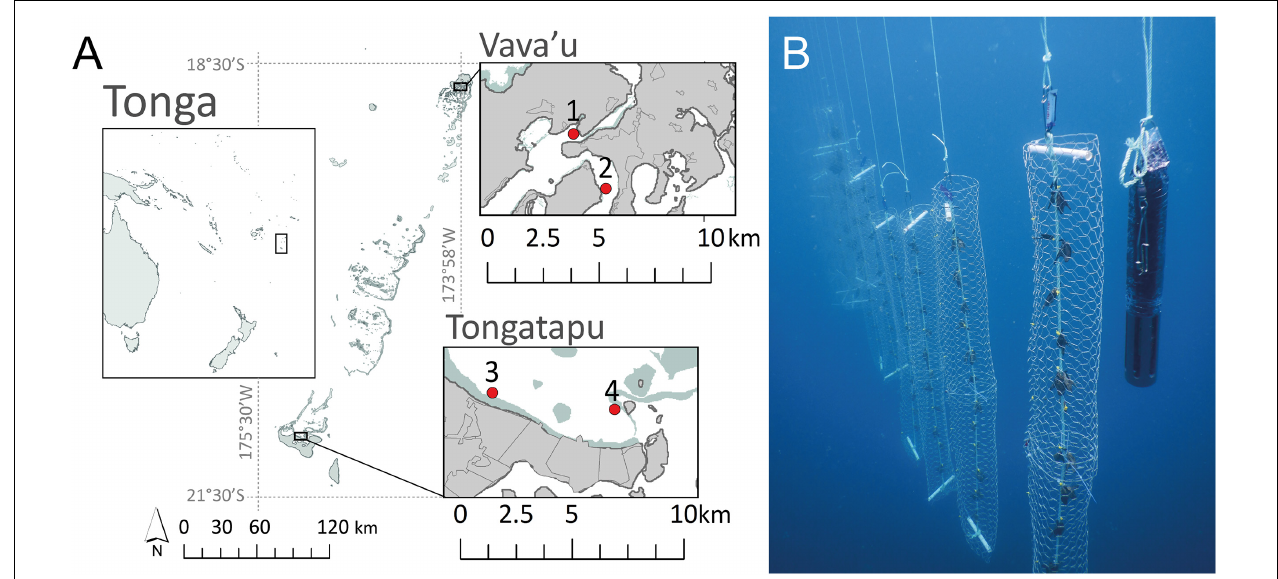
FIGURE 1 | (A) Location of Pteria penguin culture sites in the Kingdom of Tonga: (1) Vaipua, (2) Utulei, in Vava’u, (3) Sopu, and (4) Pangaimotu in Tongatapu. Gray and green regions represent land and reefs, respectively. (B) “Young” Pteria penguin oysters housed in culture cylinders beside a multi-parameter sonde suspended from a pearl longline in Tonga [adapted from Gordon et al.